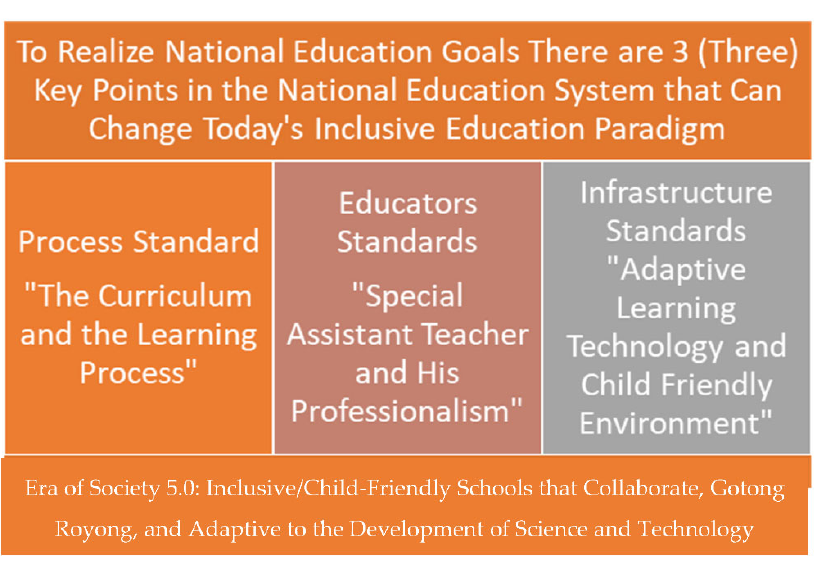
Figure 2. Inclusive Education Learning Design Modeling Era of Society 5.0.